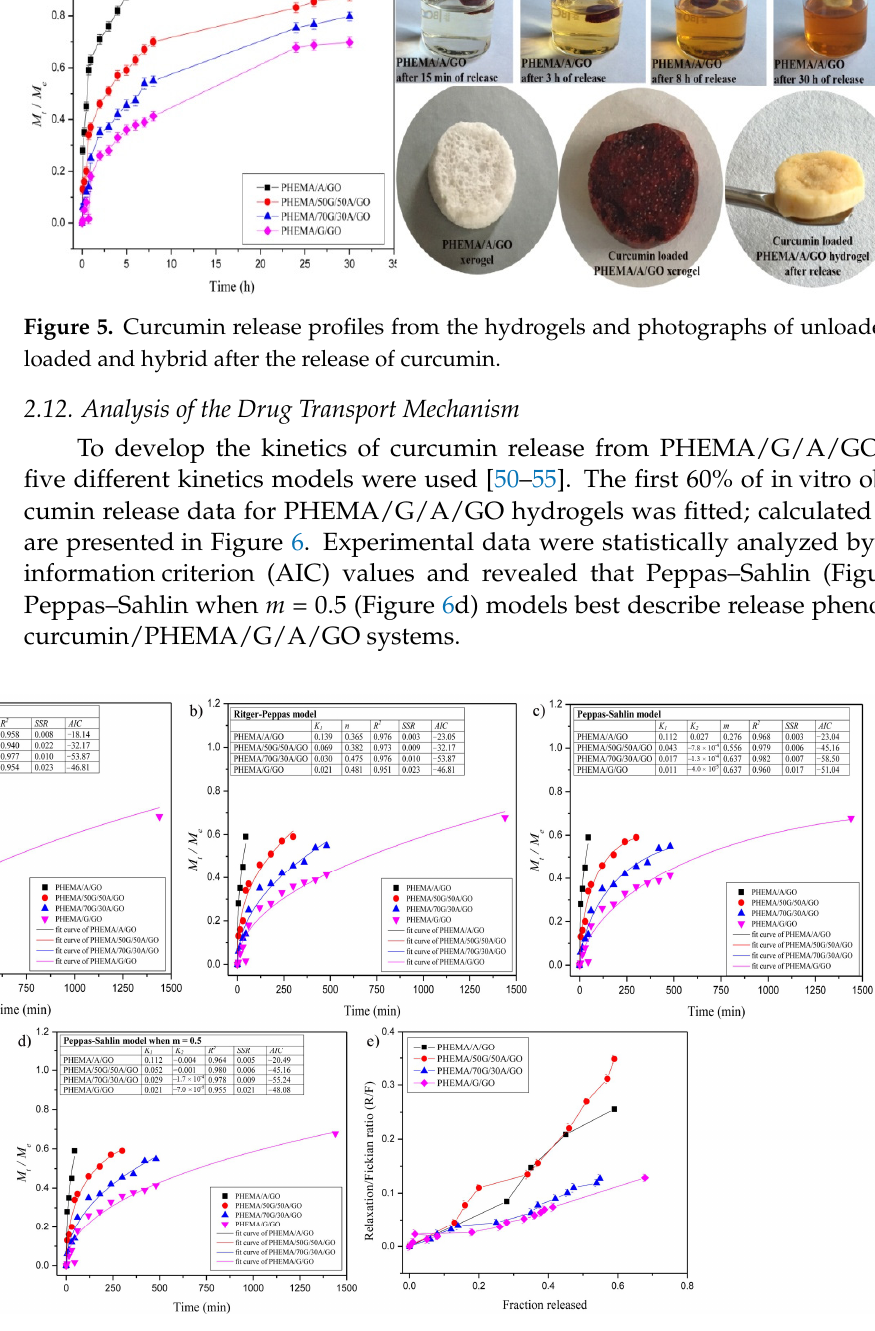
Figure 6. Obtained experimental data of curcumin release from the hybrids fitted by: ( a ) Higuchi; ( b ) Ritger–Peppas; ( c ) Peppas–Sahlin; ( d ) Peppas–Sahlin model when m = 0.5; ( e ) the ratio R/F versus the fraction of curcumin released from the hybrid